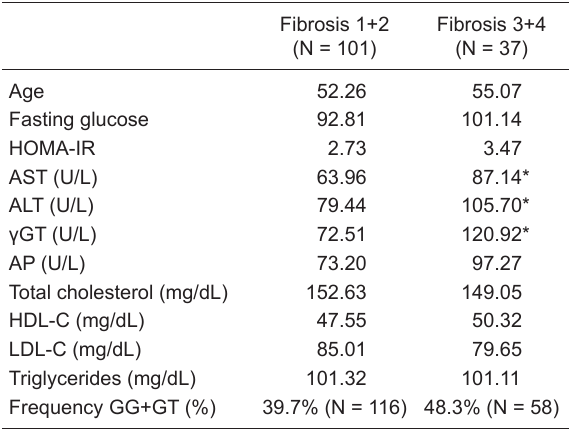
Table 2 . Clinical and biochemical characteristics of chronic hepa- titis C patients according to fibrosis stage.